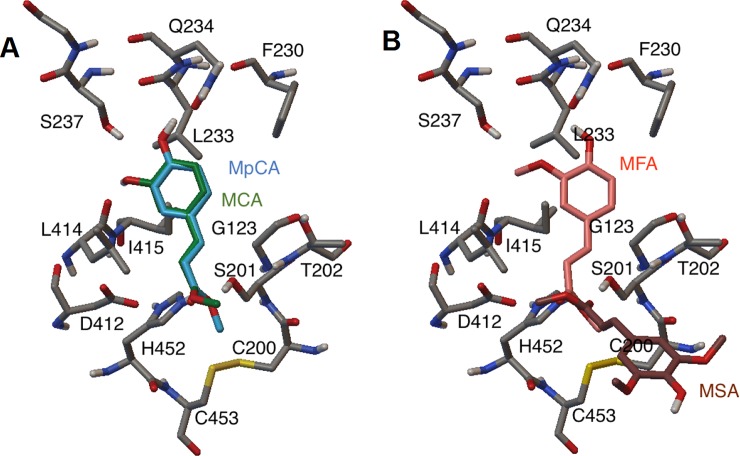
Position of ligands docked into FoFaeC wild type.(A) MCA and MpCA (B) MFA and MSA. Phe349 and Tyr351 were removed for clarity.